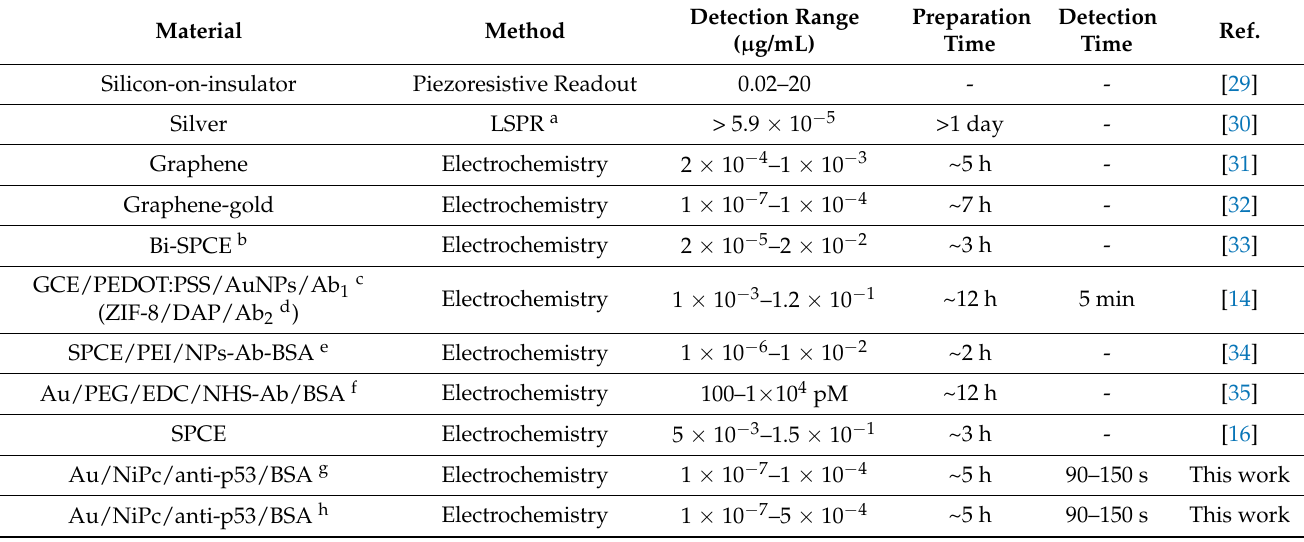
Table 2. Comparison of different methods for detecting p53 proteins